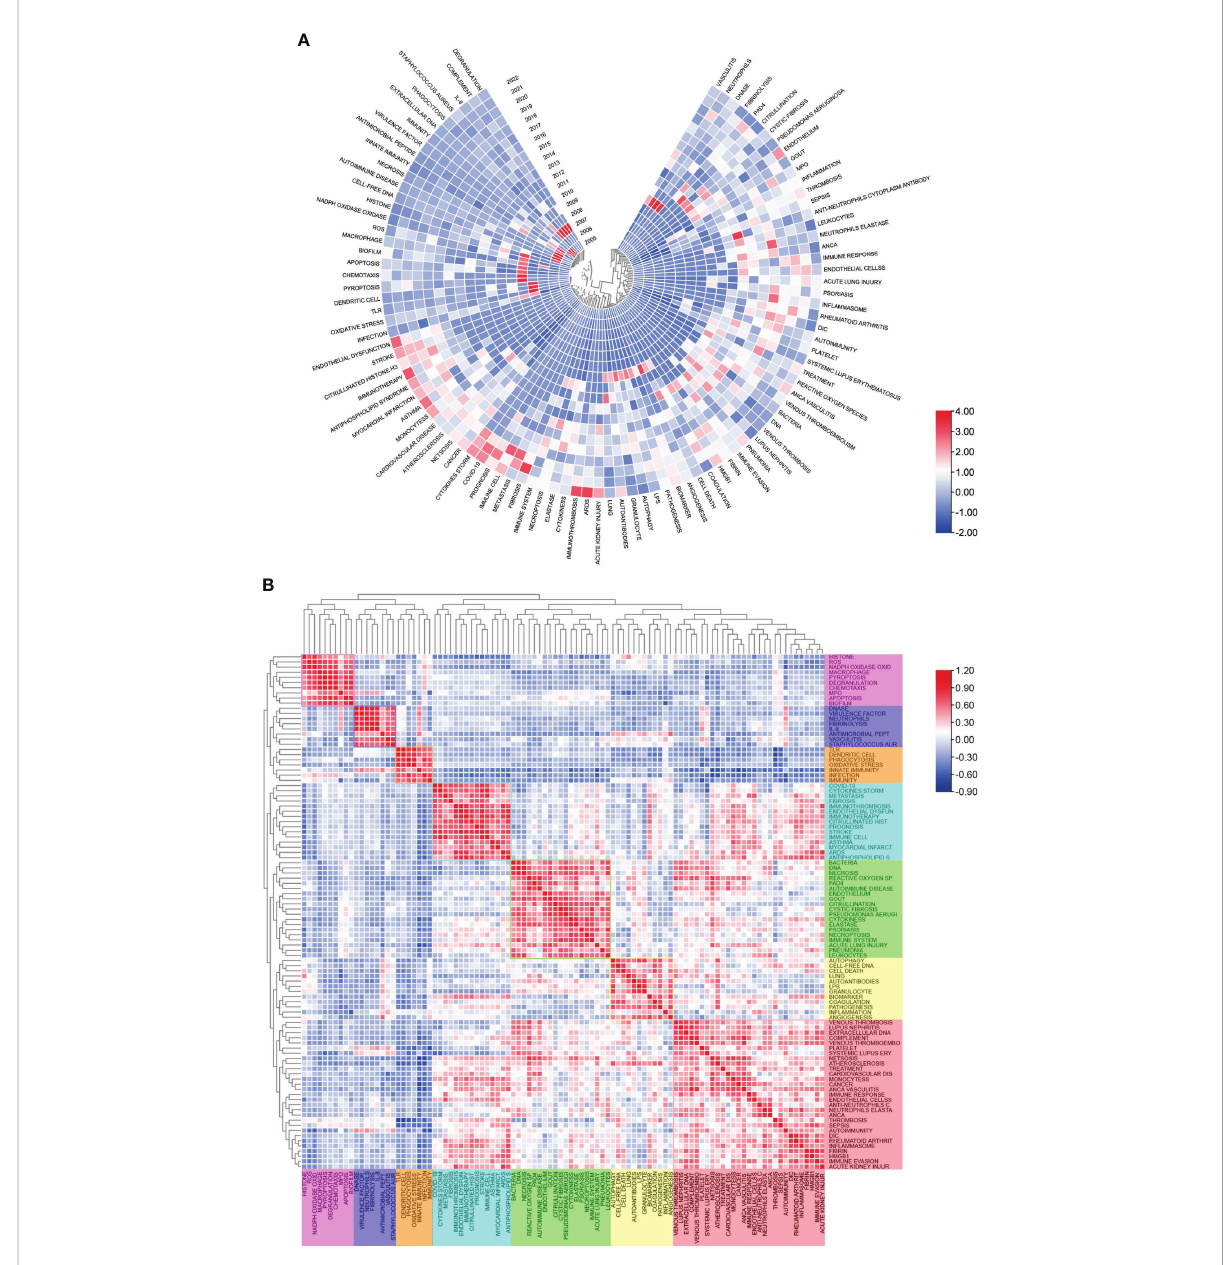
FIGURE 7 Heatmap analysis of NETs-related keywords. (A) Annual heatmap from 2004 to 2022. The annual heat value of each keyword is obtained by dividing the number of citations in that year by the total number of citations in that year. (B) Keyword relevance heatmap. Keywords with high popularity in similar time periods are clustered into one category and marked with different